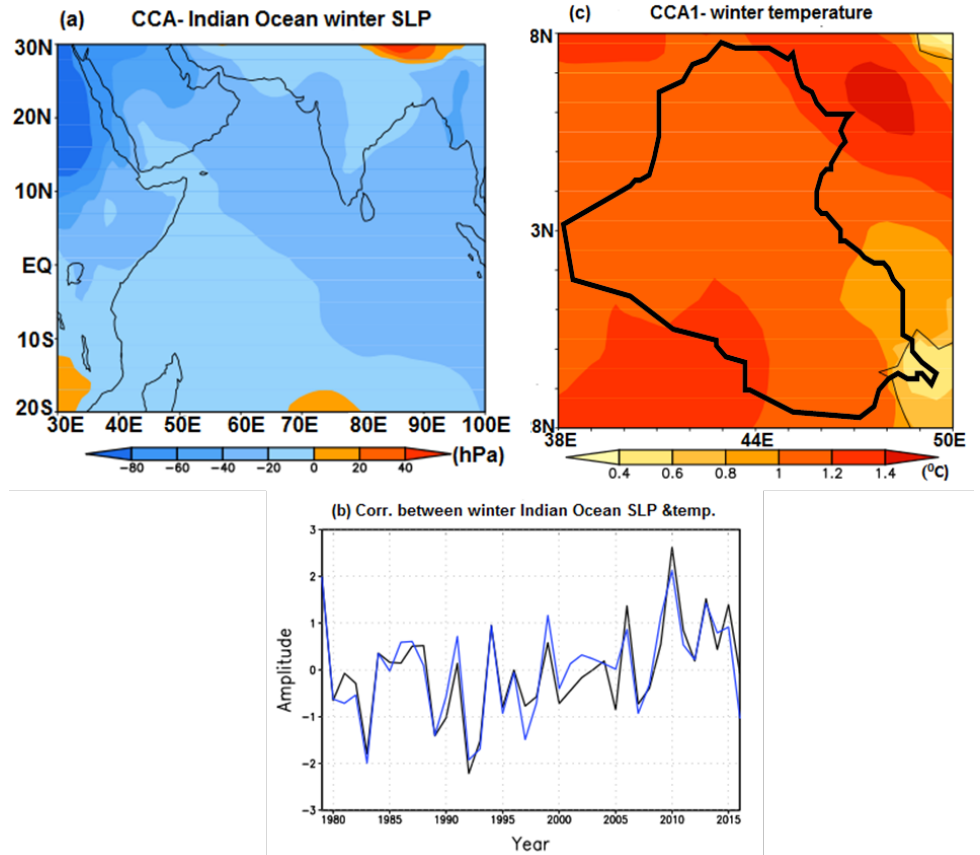
Figure 6. First pair derived through CCA between winter SLP of Indian Ocean sector and Iraq winter temperature fields, extending over the 1979–2016 period. ( a ) SLP map, explaining 13.13% of the total variance; ( b ) SLP (blue line), Iraq temperature (black line) time series associated to patterns in panels (a and c), the correlation between these two time series is 0.91; ( c ) temperature map, explaining 62.17% of the total variance. The black contour line in panel (c) marks the Iraq border.